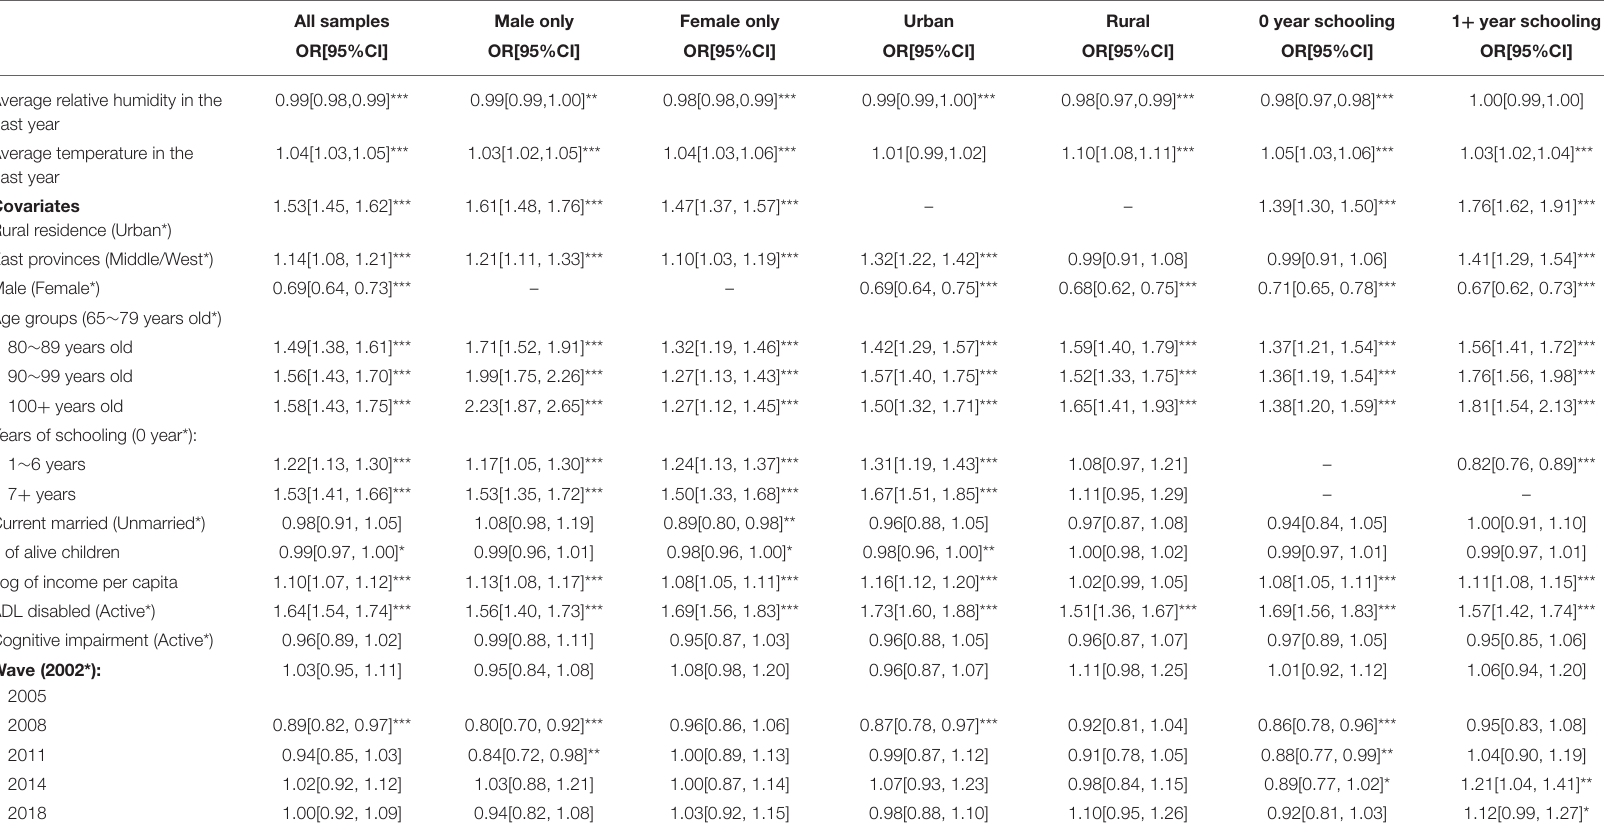
TABLE 2 | Effects of air relative humidity and temperature on Cataracts among Chinese older adults aged 65–105 during 2002–2018: Odds Ratios (OR) from GEE models. All